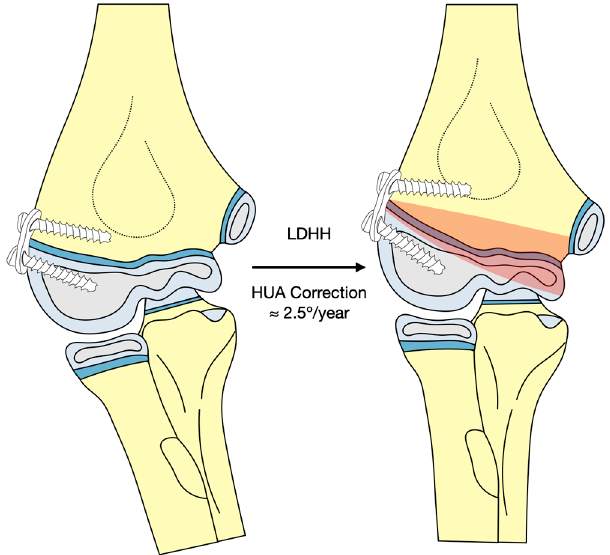
Figure 10. Illustration of the effect of the LDHH technique with the eight-Plate system for cubitus varus correction, with an approximate correction rate of 2.5° for the HUA. LDHH, lateral distal humeral hemiepiphysiodesis; HUA, humeral-ulnar angle.